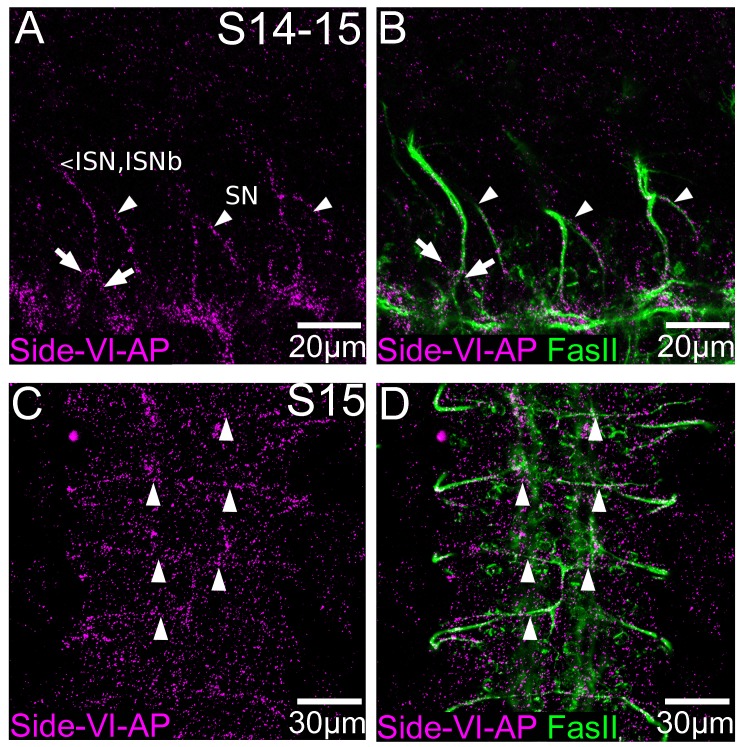
The Side-VI ectodomain binds to motor axons in live-dissected embryos.Live-dissected stage 14–15 wild type embryos were stained with Side-VI-AP (magenta) and 1D4 (green). (A, B) The intersegmental (ISN) and segmental (SN) motor nerves are labeled. The anterior (left) and posterior (right) tributaries of the ISN are labeled with arrows, while the SN is labeled with arrowheads in each segment. (C, D) Side-VI-AP binding to the transverse nerve (TN), which originates at the CNS midline, in a stage 15 embryo. The location of the TN is indicated with arrowheads. Side-VI-AP staining (magenta) is overlaid with ID4 staining (green) to show motor nerves in (B) and (D).